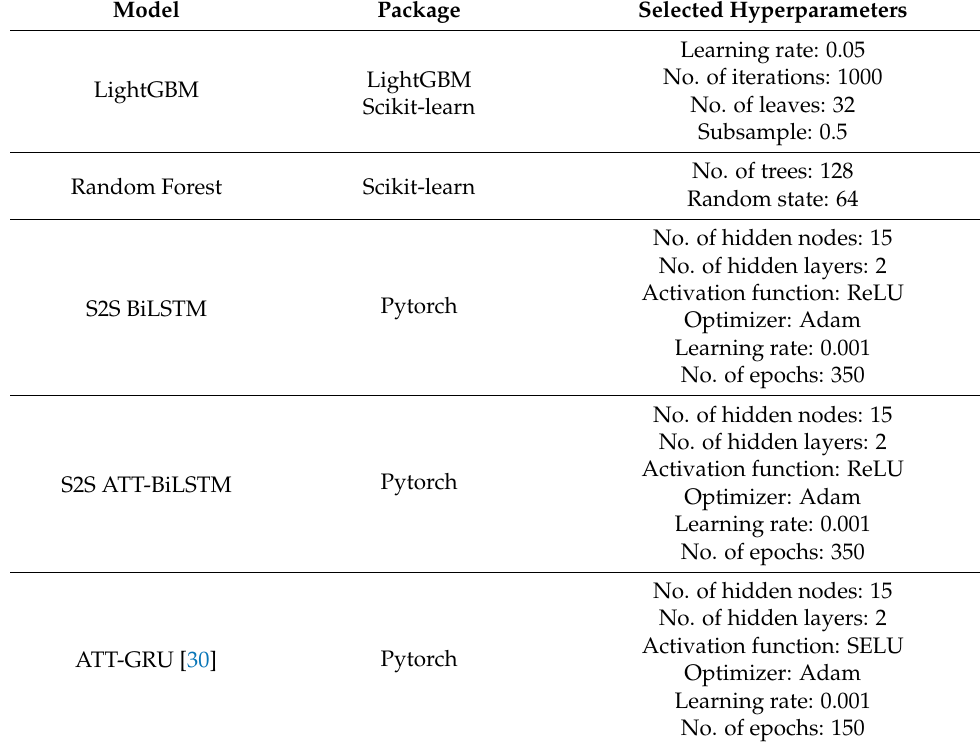
Table 6. Selected hyperparameters for each multistep-ahead forecasting